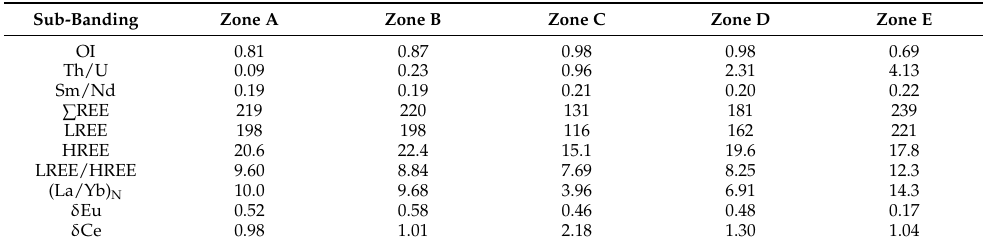
Table 4. Characteristic values of major, trace and rare earth elements of ores-fresh rocks in each zoning of Zhangjiawu uranium deposit ( × 10 − 6 ).